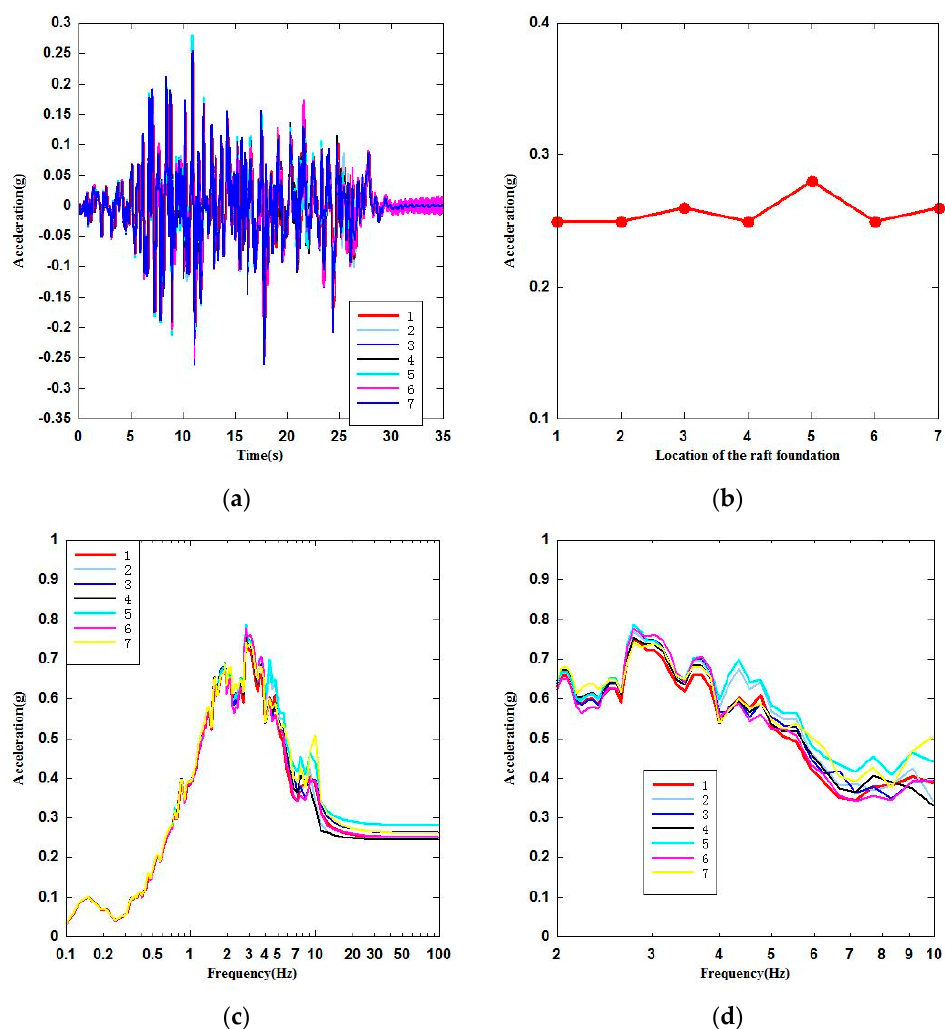
Figure 13. Peak acceleration and floor response spectrum of the raft foundation at 7 positions in the y direction. ( a ) Acceleration time history of the raft foundation in the y direction. ( b ) Peak acceleration of the raft foundation in the y direction. ( c ) Floor response spectrum of the raft foundation in the y direction. ( d ) Floor response spectrum of the raft foundation in the y direction (2–10